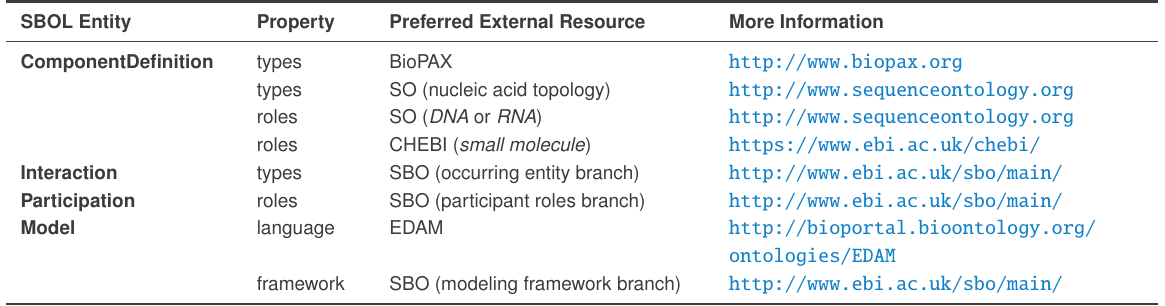
Table 17: Preferred external resources from which to draw values for various SBOL